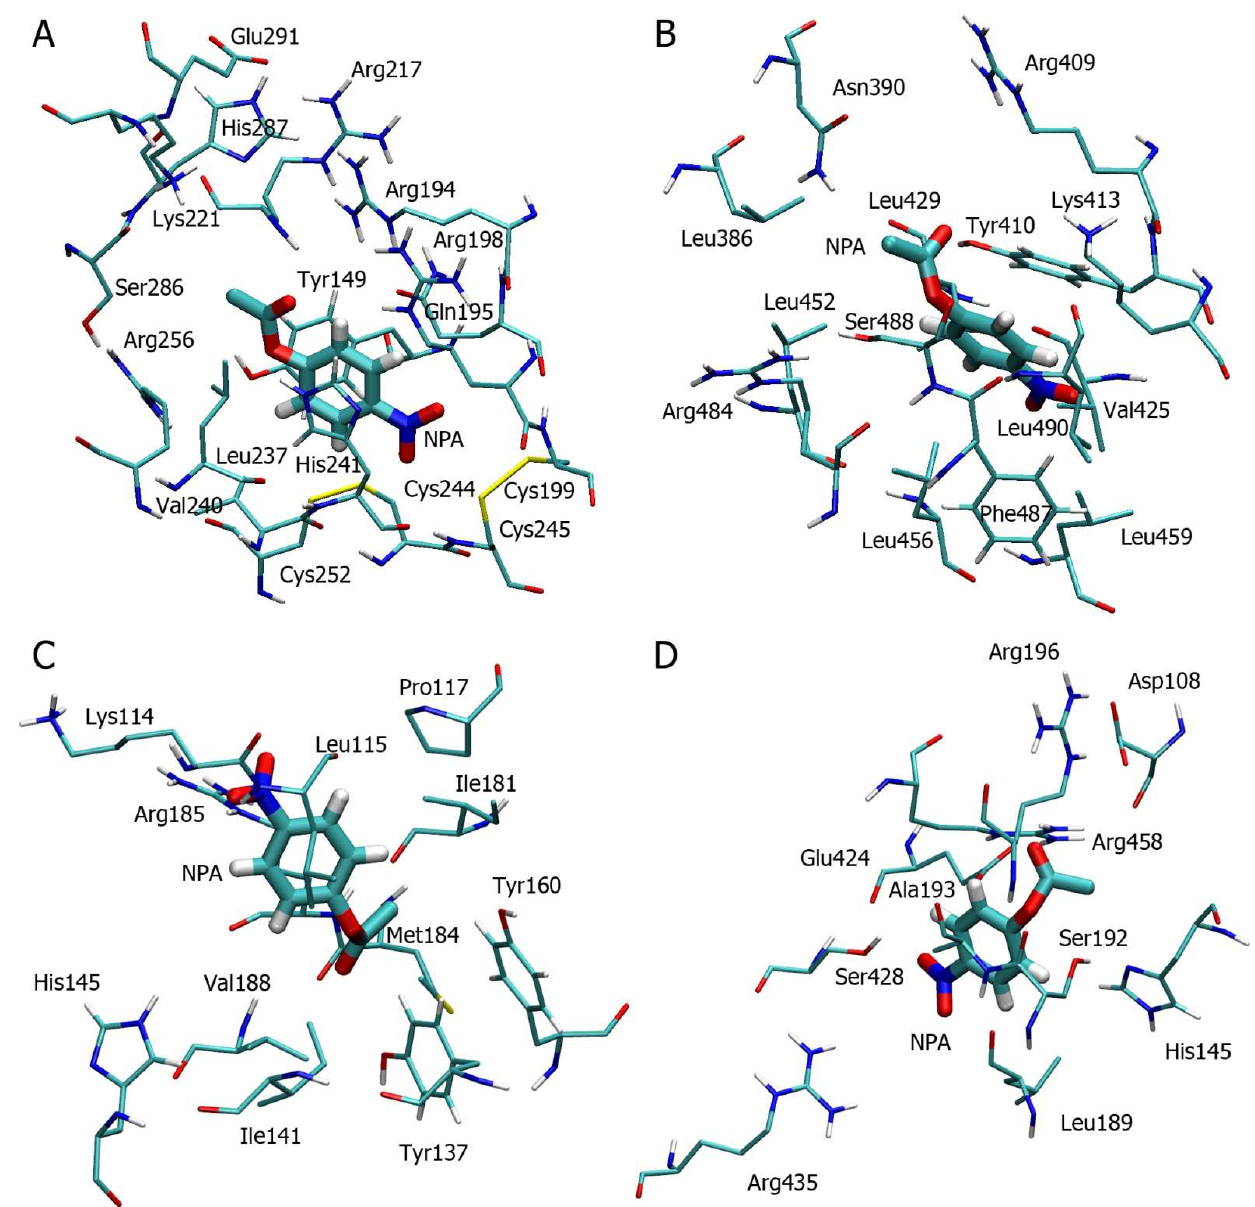
Figure 5. Result of molecular docking of NPA to ligand-binding sites of BSA. ( A ) Sudlow site I and catalytic tyrosine Tyr149, ( B ) Sudlow site II and catalytic Tyr410; ( C ) site III and catalytic Tyr137; ( D ) site III and catalytic Ser192. Due to the deletion at position 116, amino acid numbering in BSA after amino acid residue 115 is shifted one position relative to HSA.